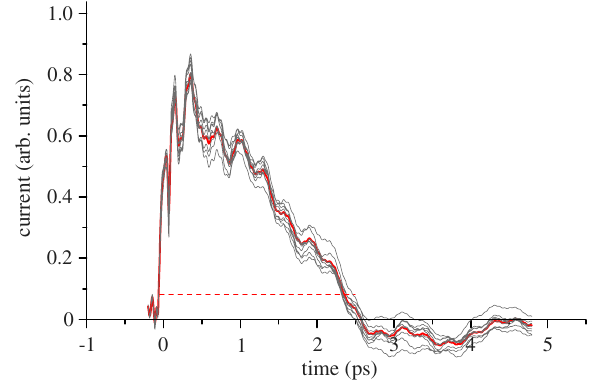
FIG. 10. Bunch profile during a “ medium compression ” run (April 9,